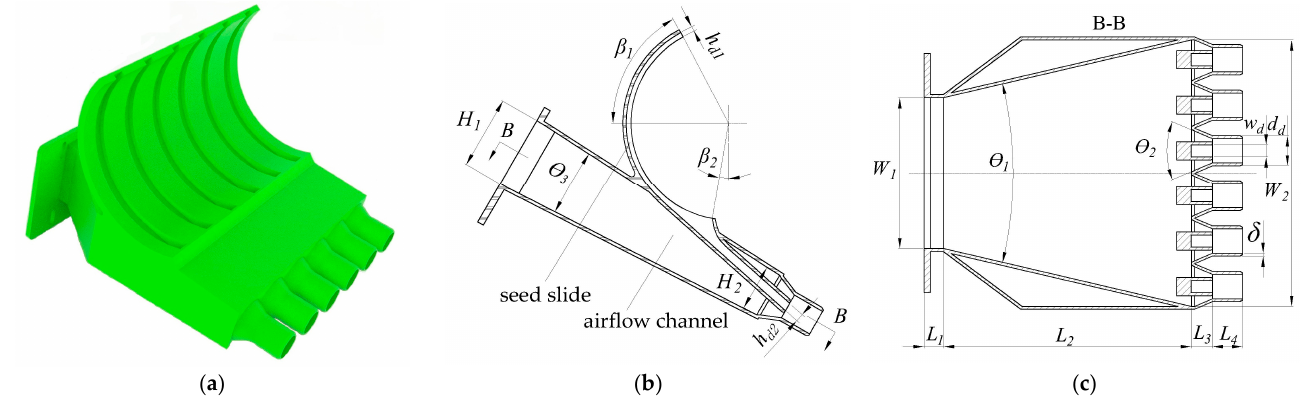
Figure 4. ( a ) Outside view of distribution manifold; ( b ) right side cutaway drawing of distribution manifold; ( c ) structural diagram of B–B section plan of airflow dispenser.